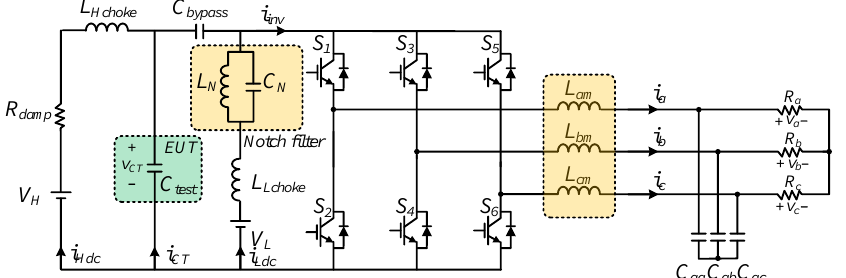
Figure 3. Proposed down-scale voltage rating evaluation system.